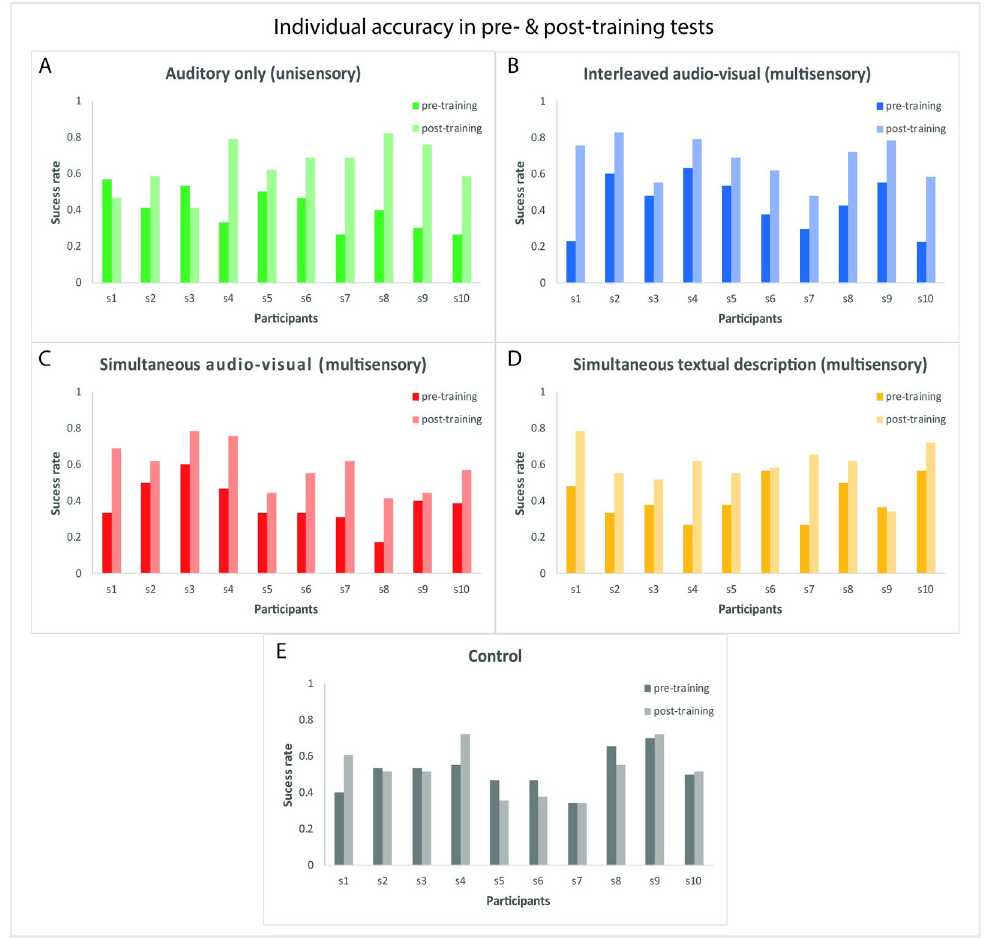
Fig 5. Individual accuracy in pre- and post-training SSD identification test, separated for each experimental group. Each graph shows the success rate of a single participant in pre-training (dark bars) and post-training SSD identification tests (light bars). A. Auditory only (unisensory) training group: 8 out of 10 participants improved their success rate in the post-training test compared to their pre-training performance. B. Interleaved audio-visual (multisensory) training group: all participants improved their success rate in the post-training test compared to their pre-training performance. C. Simultaneous audio-visual (multisensory) training group: all participants improved their success rate in the post- training test compared to their pre-training performance. D. Simultaneous textual description (multisensory) training group: 9 out of 10 participants improved their success rate in the post-training test compared to their pre-training performance (note that 1 out of these 9 participants showed a very minimal improvement in the post-training test). E. Control group: 4 out of 10 participants improved their success rate in the post-training test compared to their pre-training performance (note that 2 out of these 4 participants showed a very minimal improvement in the post-training test).